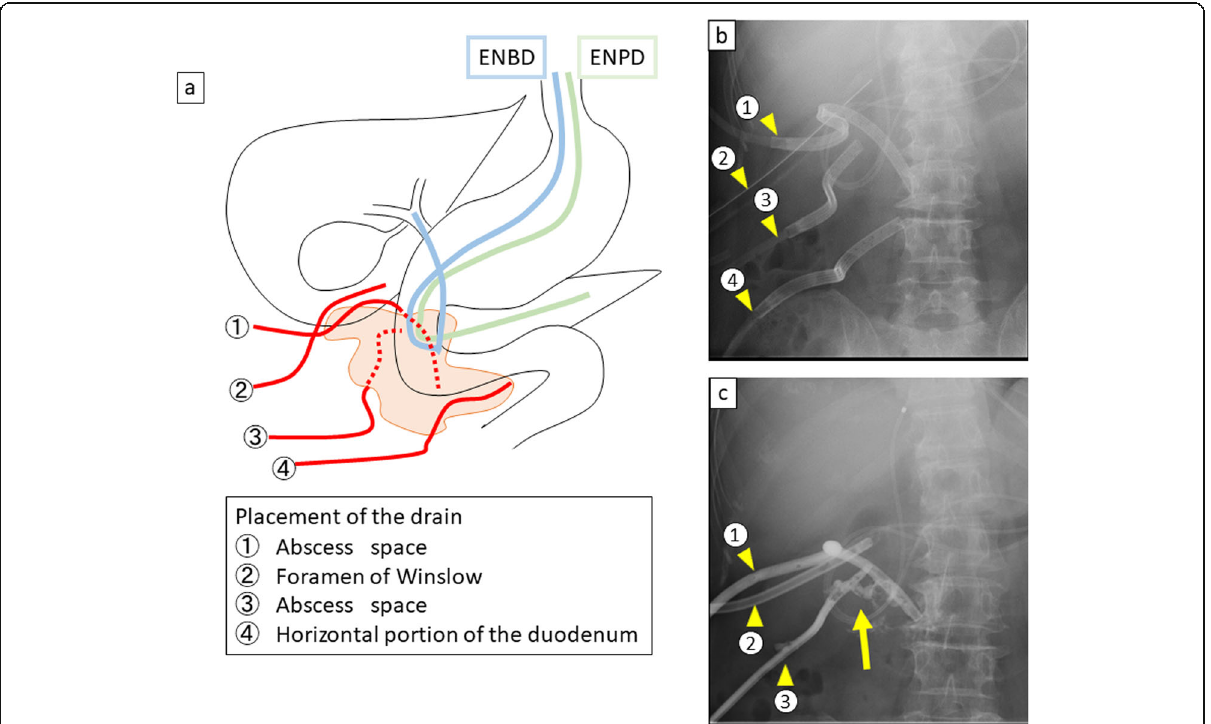
Fig. 2 a The scheme of the treatment strategy. Four indwelling tubes ( ① abscess space, ② foramen of Winslow, ③ abscess space, and ④ horizontal part of the duodenum) were placed intraoperatively. Furthermore, endoscopic nasobiliary drainage (ENBD) and nasopancreatic drainage (ENPD) tubes were placed on postoperative day (POD) 2. b The picture after endoscopic retrograde cholangiopancreatography (ERCP) on POD 2. Yellow arrowheads show the placement of four indwelling tubes. c The picture of contrast radiography on POD 20, which revealed a fistula between the abscess space and the duodenal diverticulum (yellow arrow). The drain placed on the horizontal part of the duodenum was already removed, and yellow arrowheads show that the three indwelling drains